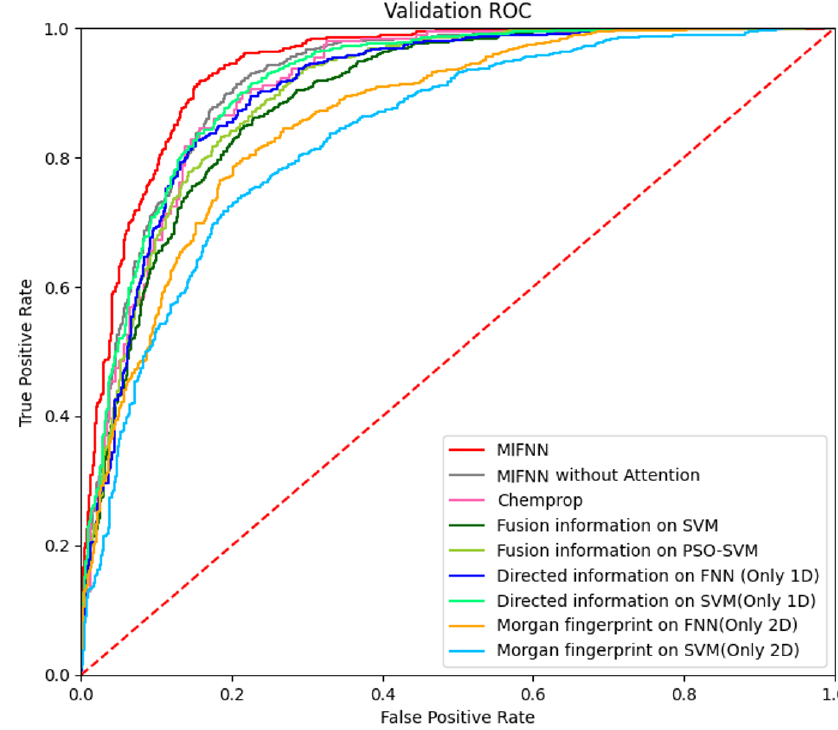
Figure 9. Visualization of model optimization results.